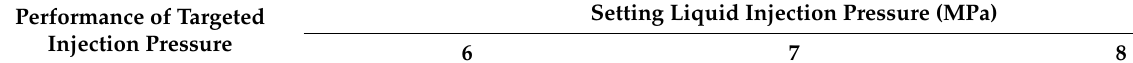
Table 1. Average liquid jet pressure and device control of the needle-free in ovo injection device at 6–8 MPa.